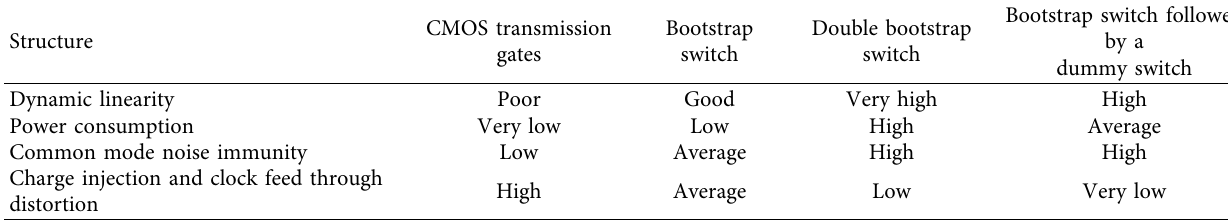
Table 1: Comparison between diferent SAH